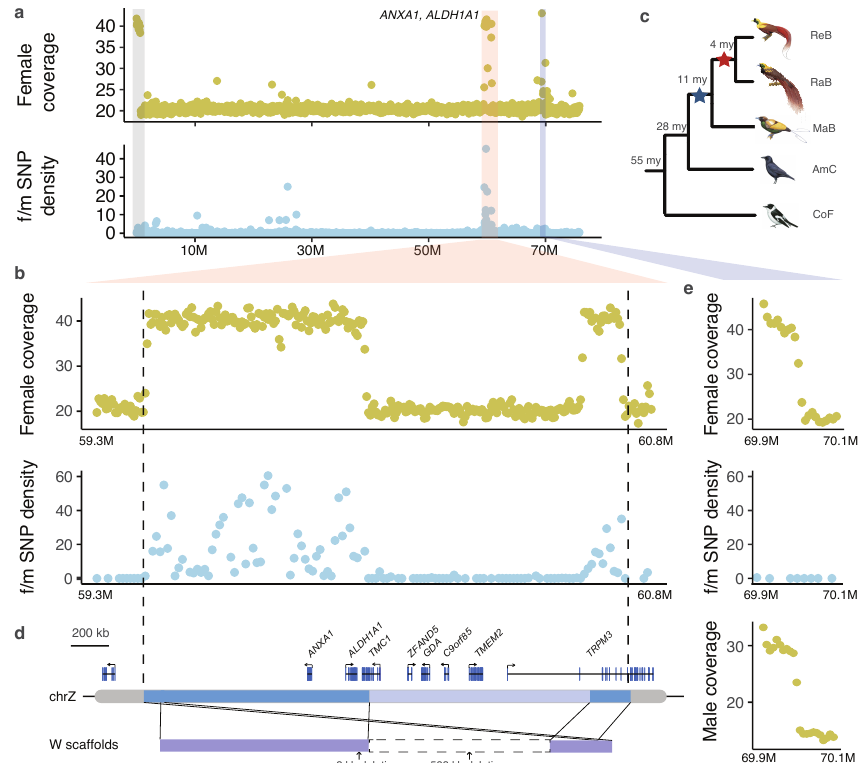
Figure 1. A transposition from the Z to W chromosomes in birds-of-paradise. ( a ) the genomic region at ~60 Mb of the Z chromosome showing doubled female sequencing coverage and female-specific elevations of heterozygosities (“f / m SNP density”) was inferred as a recent Z-transposed region (ZTR), and is marked by a red vertical bar. Two genes that survived following ZTR were labeled close to the red vertical bar. PAR and Z-linked duplications (marked in gray and purple vertical bars) are not expected to show a female-specific elevation of SNP densities. ( b ) A zoom-in view of the ZTR, showing female coverage and female-to-male SNP density calculated in 50 kb windows. ( c ) The phylogeny of birds-of-paradise (BOP) showing the origin of the ZTR (red asterisk) and the Z-linked duplication (blue asterisk). ReB: red BOP, RaB: Raggiana BOP, Mab: magnificent BOP, AmC: American crow, CoF: collared flycatcher. All bird illustrations were ordered from https: // www.hbw.com / . ( d ) The 1.3 Mb transposed sequence (vertically aligned with (B)) contains 8 genes, but 4 complete and 2 partial genes have been deleted due to a 583 kb long deletion. Only ANXA1 and ALDH1A1 were retained on the W after transposition. ( e ) A zoom-in view for the duplication that does not show elevated female-to-male SNP density and both female and male coverage are